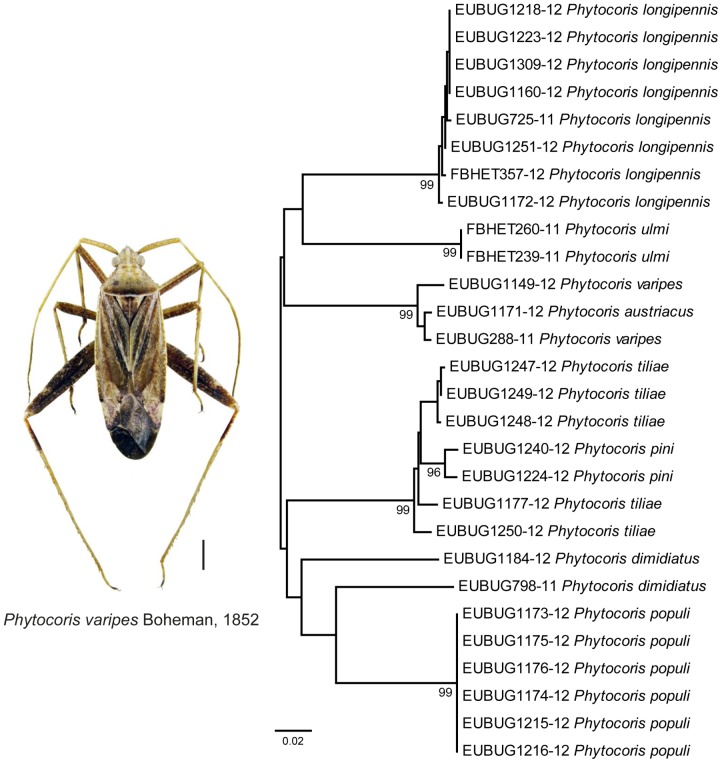
Subtree of the neighbour joining tree based on Kimura 2-parameter distances of all studied specimens of the genus Phytocoris (Miridae).Branches with specimen ID-number from BOLD and species name. Numbers next to internal branches are bootstrap values (in %). Scale bar  = 1 mm.